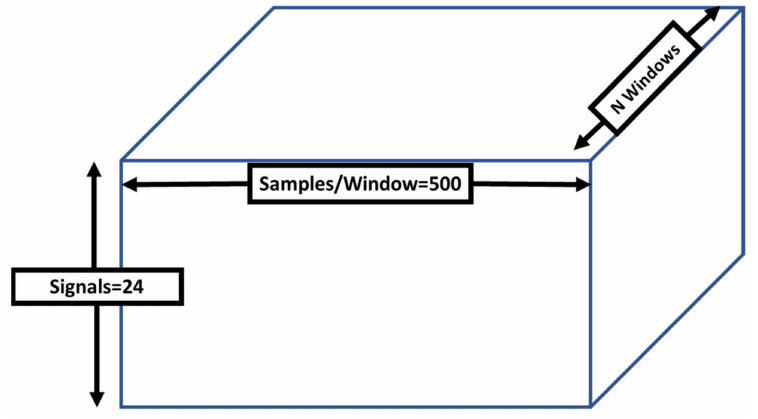
Figure 2. The long short-term memory (LSTM) network’s input data structure. Table 2. Specifications of the proposed long short-term memory (LSTM) model for the physical activity classification